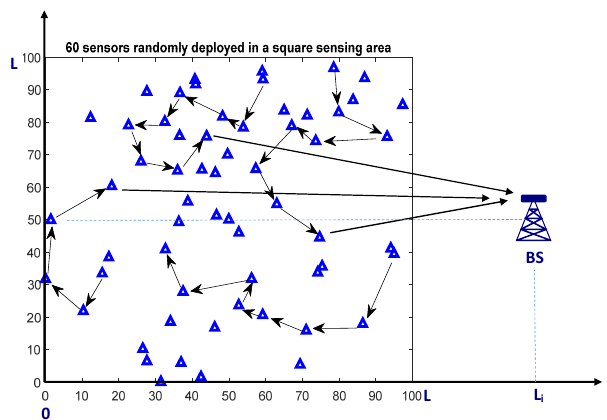
Figure 3. RWs collect sensory readings and send directly CS measurements to the BS at ( L